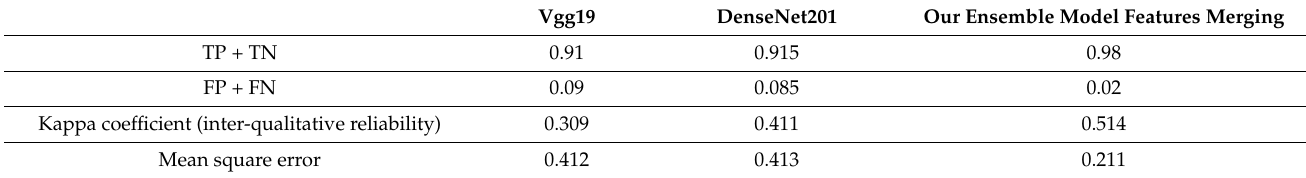
Table 7. Statistics metrics for the compared models for the TwitD dataset. Vgg19 DenseNet201 Our Ensemble Model Features